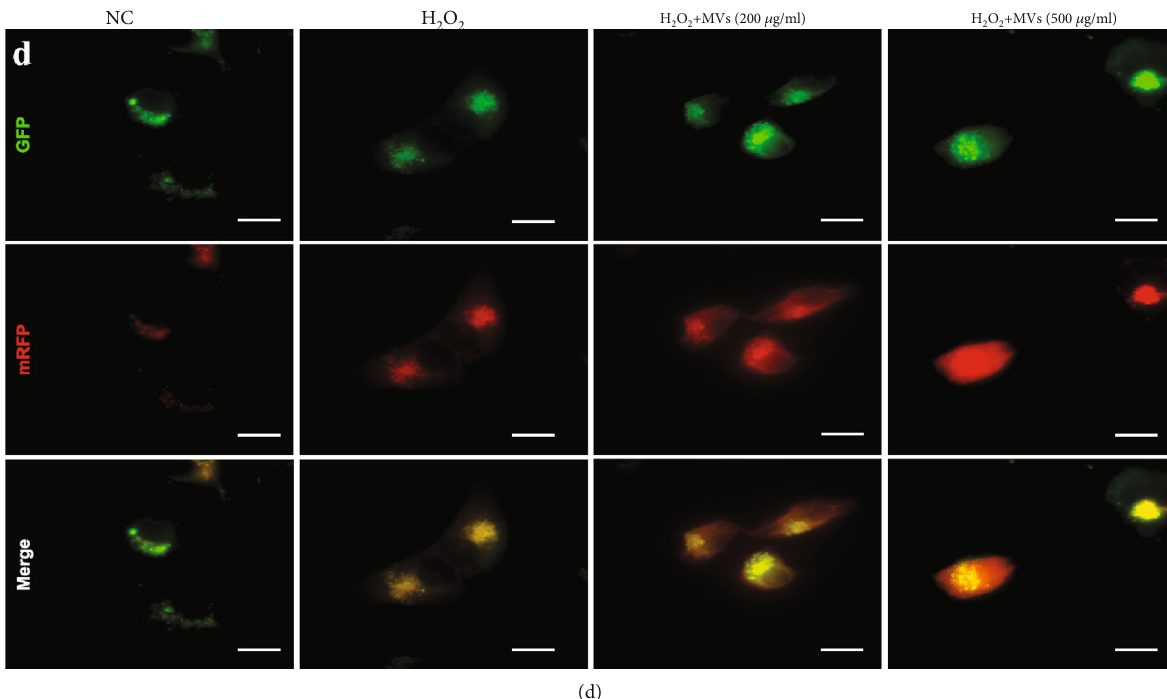
Figure 4: hESC-NSC-derived MVs increased the level of cell autophagy after H the protein levels of LC3, Beclin-1, and P62. β -Actin was used as an internal control (a, b). Autophagosomes were detected by tandem fl uorescent mRFG-GFP-LC3 assay, scale bars: 15 μ m (c). Autophagosomes (white arrow) were measured by TEM in four groups, scale bars: 2 μ m (d). Every experiment was repeated at least three times; error bars indicate mean ± SD ( ∗ P < 0 : 05 ; ∗∗ P < 0 : 01 ; ∗∗∗ P < 0 : 001